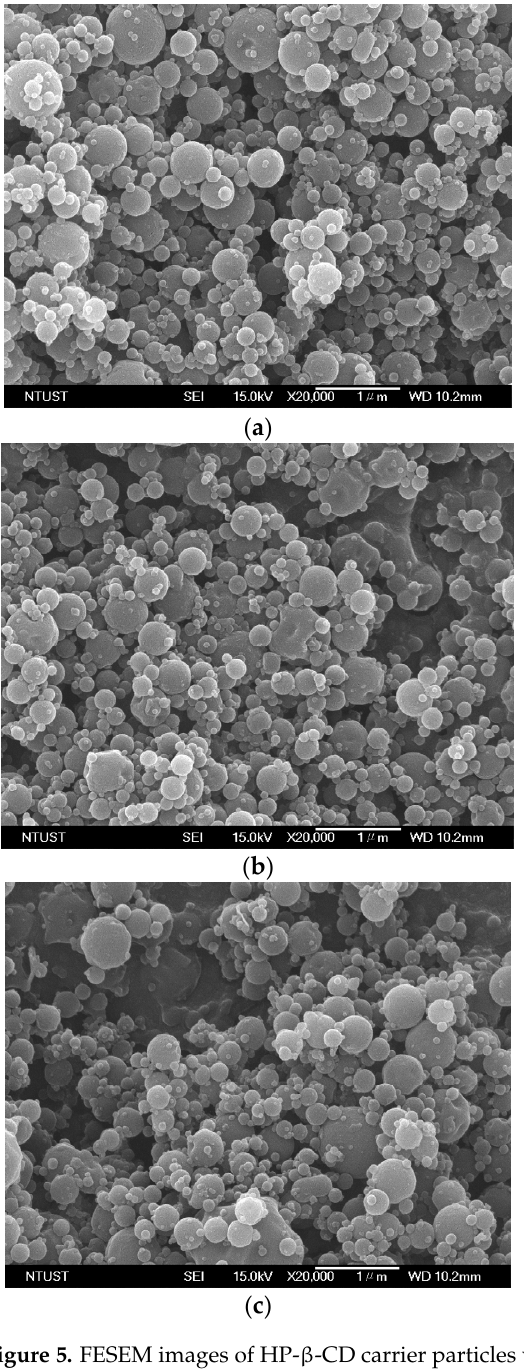
Figure 5. FESEM images of HP- β -CD carrier particles with differing addition of leucine (mass%) produced through SAA: